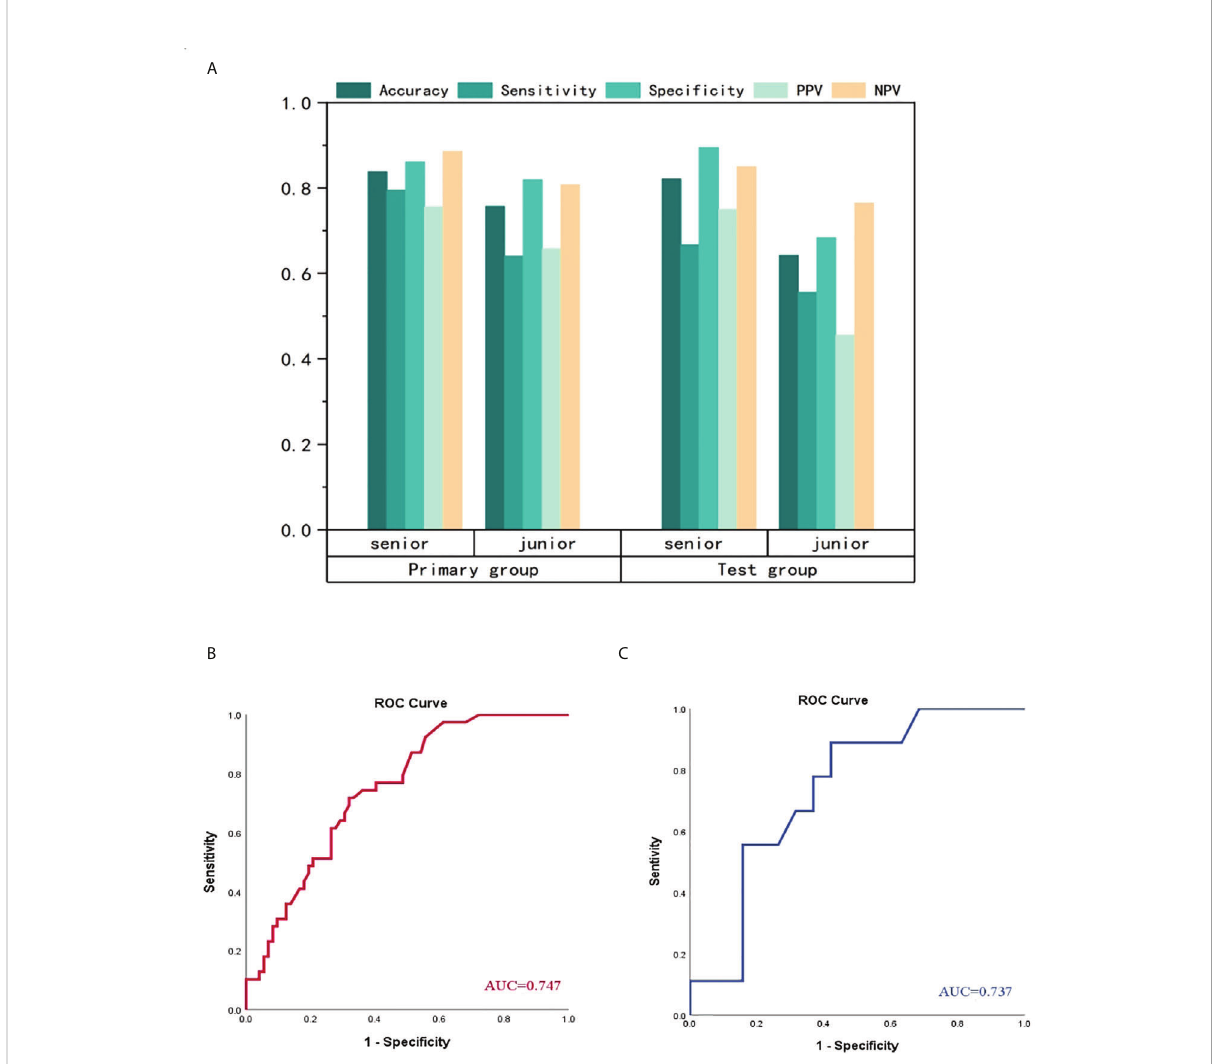
FIGURE 7 Comparison of performance among radiologists and clinical model (A) represented manifestation of senior radiologist and junior radiologist. No matter in primary group or test group, the senior radiologist performed better than junior radiologist. The clinical model achieved ordinary performance in primary group (B) and test group (C) , which is the worst among CNN models, radiologists and clinical